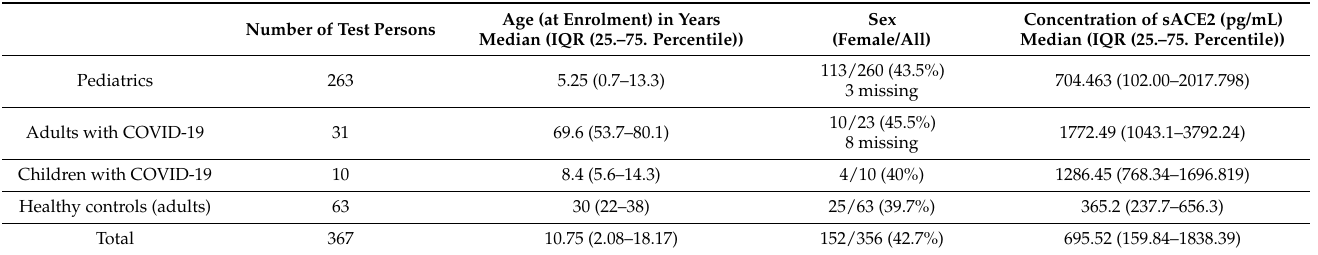
Table 1. Overview of the number of test person, age, sex and sACE2 concentration (pg/mL) in the different groups, given as median (interquartile range (25–57 percentile)).